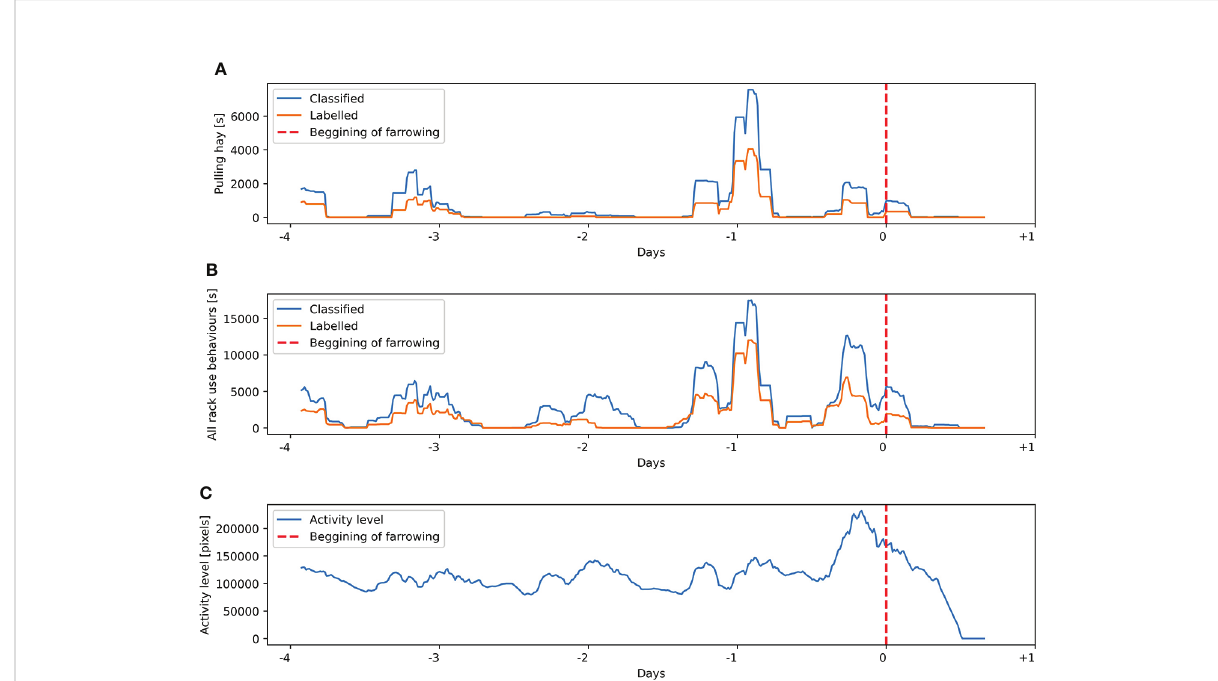
FIGURE 9 Labeling and classi fi cation for sow 1 from the training dataset of (A) pulling hay behavior and (B) all hay rack use behaviors. (C) Activity level estimated on the basis of the Euclidean distance between the centroids of the sow ’ s body in consecutive frames. Presented variables are calculated on a sliding window of 4 h with 15 min